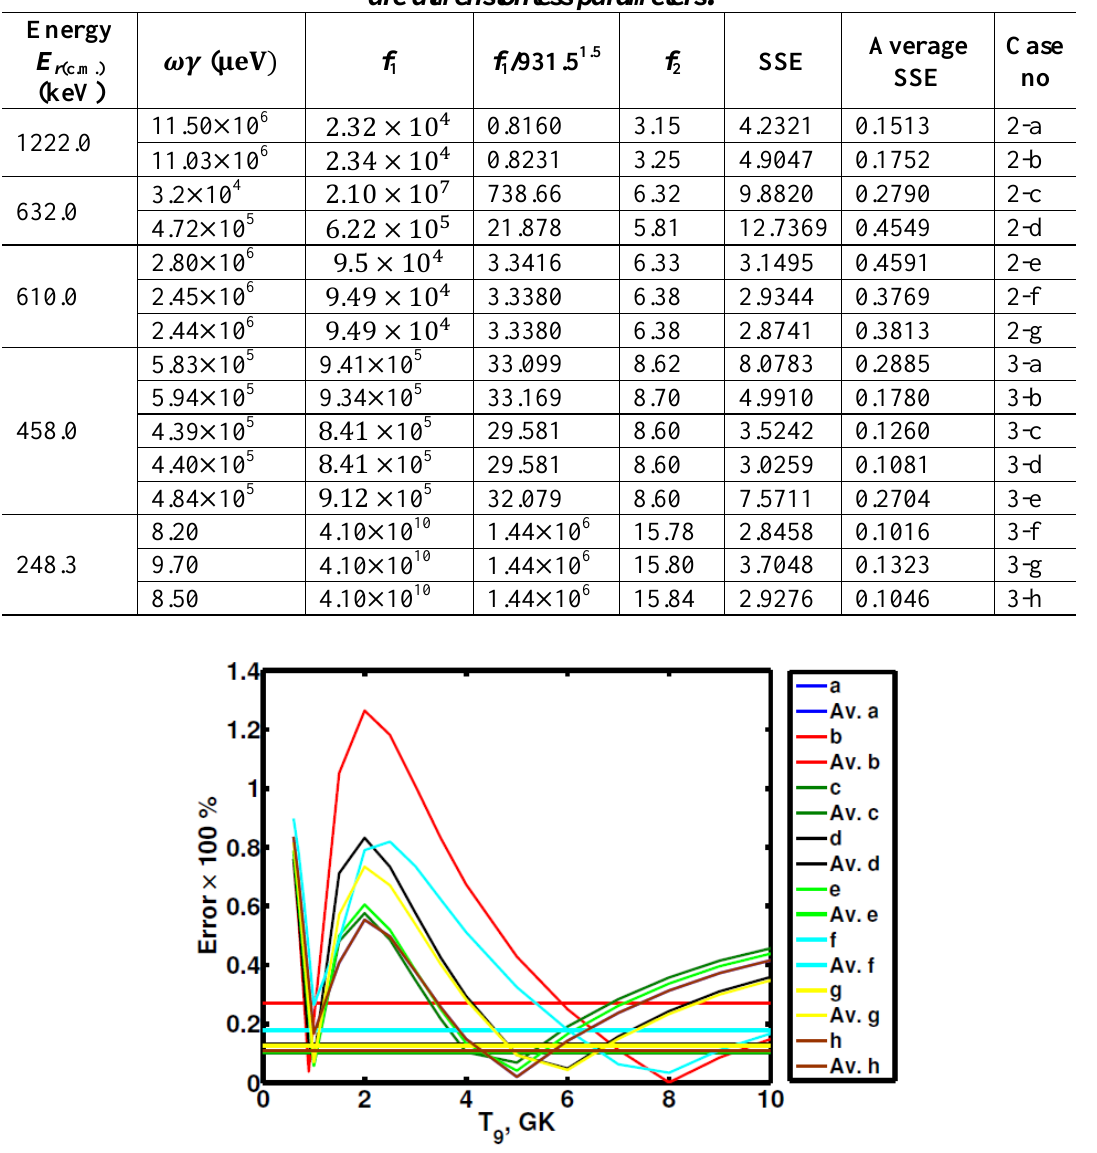
Figure 2: Relative error (curved lines) and average error (straight lines) for the difference between theoretical and calculated reaction rates for all temperature range before applying the correction from the fitting procedure. Theoretical values were taken from BRUSLIB [10]. Shown are the results taken from Table (3) for E =1222.0, 632 and 610 keV ( cases 2-a to 2-g). r Temperature range was T =0.001 to 9